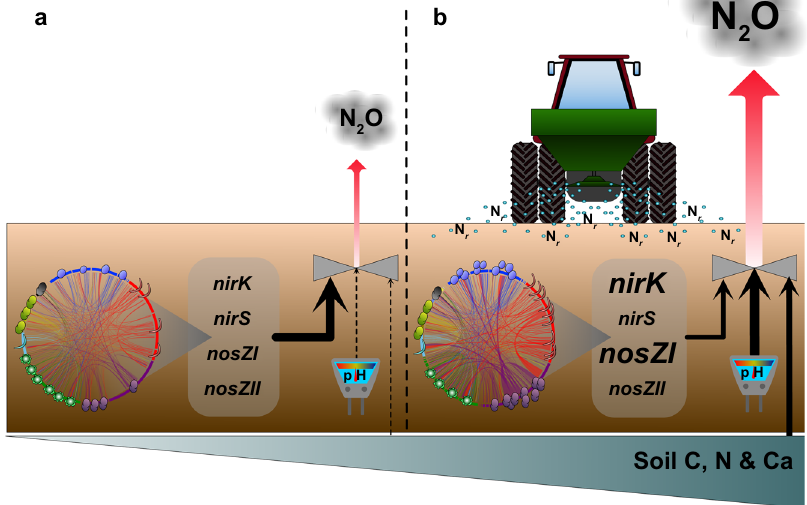
Fig. 5 Conceptual model of the effect of long-term addition of reactive N on microbial controls of N 2 O emissions. a In unfertilized soils, changes in biotic factors associated with microbial communities, such as their diversity, patterns of co-association and abundances of functional genes, exert stronger control over potential N 2 O production compared to abiotic factors including soil pH and resource levels. b Long-term addition of reactive N through fertilization restructures microbial communities over time, resulting in increased complexity of microbial co-association networks as well as altering denitri fi cation functionality through increased abundances of nirK and nosZ clade I genes associated with denitri fi cation and N 2 O reduction. However, abiotic soil factors, especially soil pH, become more important in determining potential N 2 O emission than changes in microbial